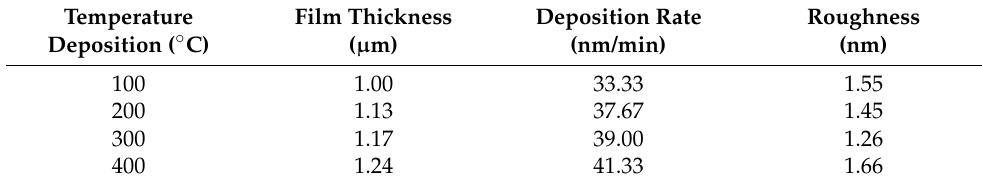
Table 2. The effects of Sputtering Temperature on the Structural Properties of Sb 0.14 GaN Film.